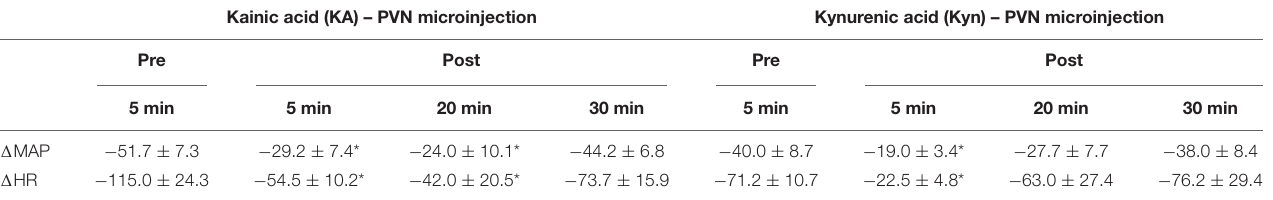
TABLE 1 | The role of PVN and glutamatergic system in PVN during Bezold-Jarisch reflex responses. Kainic acid (KA) – PVN